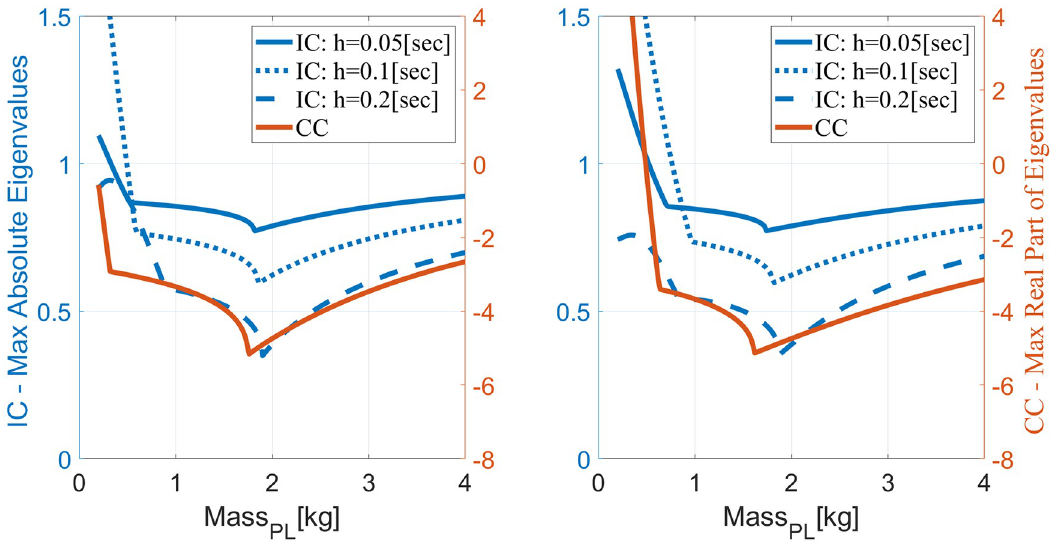
Fig 2. Eigenvalue analysis for reaching movements with LTI plant, observer and controller under IC with different h (blue lines) or CC (red line) when m IM = 2[Kg] as a function of m PL 2 [0.2, 4][Kg]. Left y-axis: intermittent control (IC). Right y-axis: continuous control (CC). Left panel: nominal measurement noise with covariance matrix V = V 0 . Right panel: less noisy measurements with V = V 0 /10. IC results in a discrete system, so stability is lost when the maximal absolute eigenvalue is larger than one, while CC results in a continuous system so stability is lost when the maximal real part of the eigenvalues is positive. Those two thresholds are aligned to facilitate comparison.